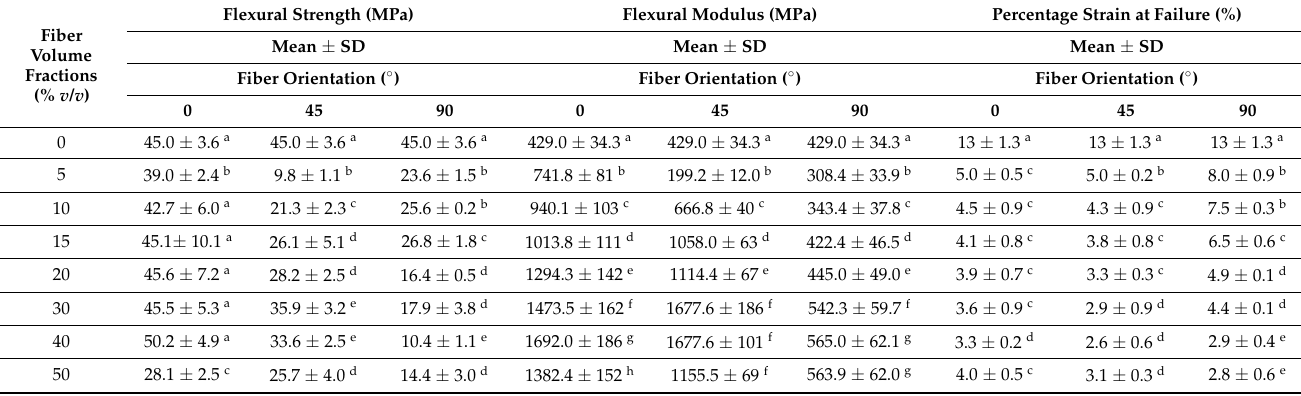
Table 2. Mean flexural strength, modulus and strain at failure of PALF/MMA composite with 0, 5, 10, 15, 20, 30, 40 and 50 v / v PALF at 0, 45 and 90 ◦ fiber orientation. Values are the means of three experiments with a standard error. Fiber